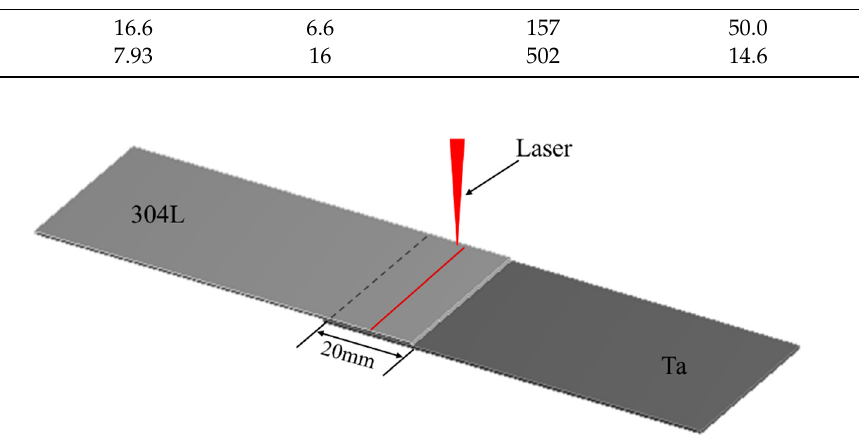
Figure 1. Schematic diagram of laser welding process for Ta to 304L.